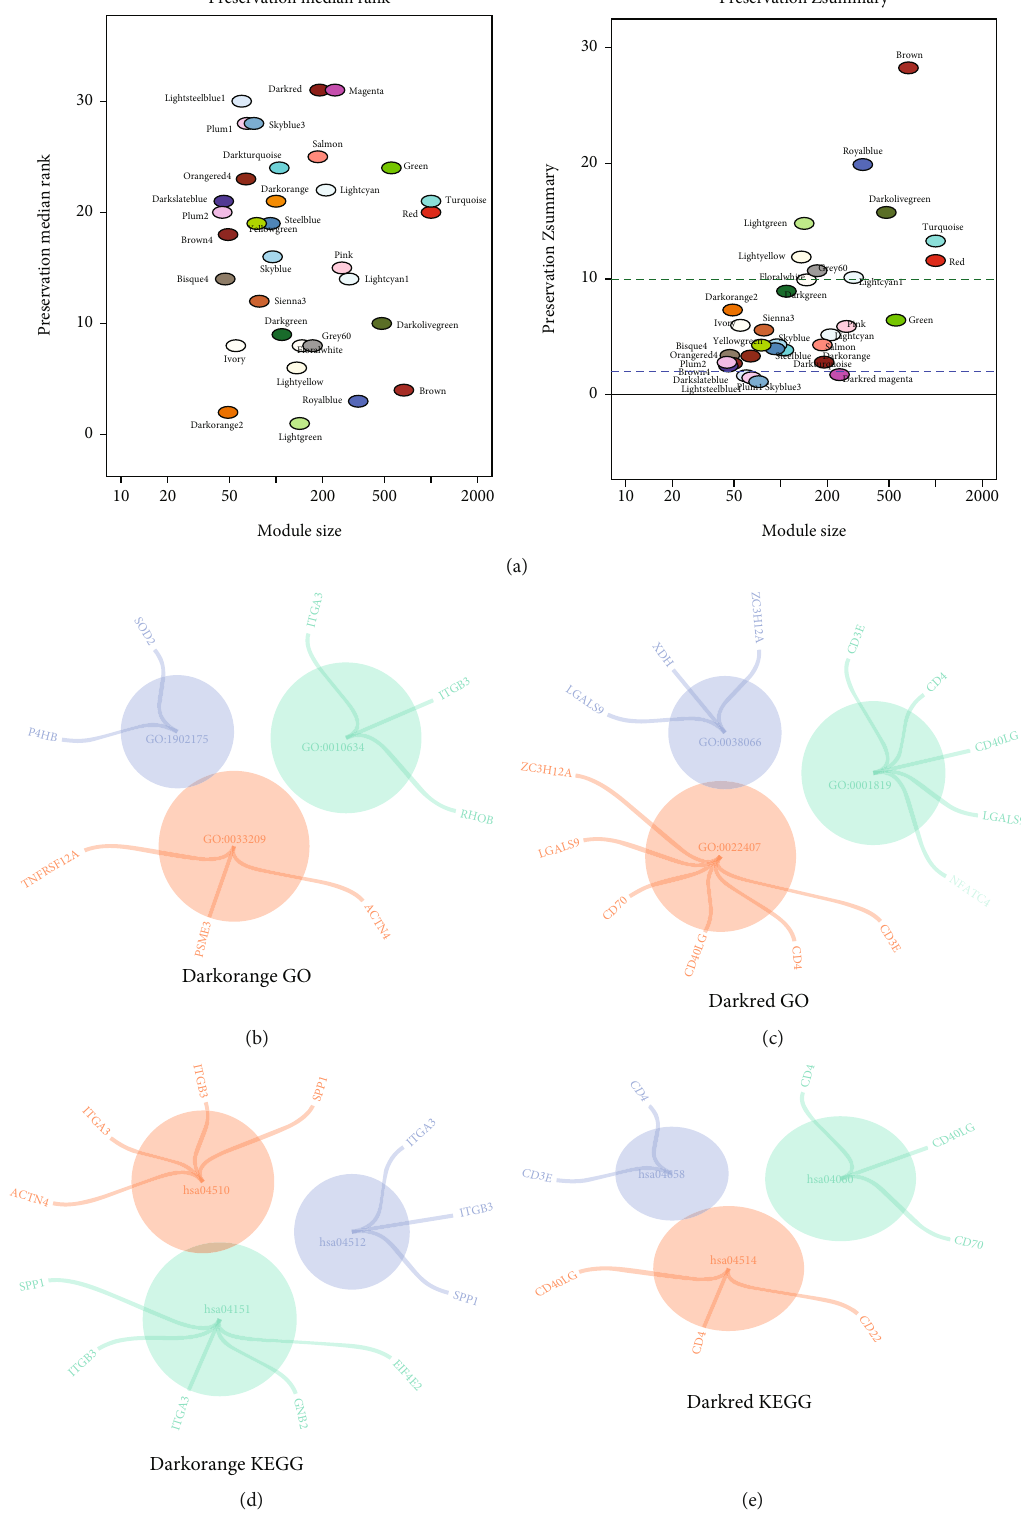
Figure 2: Characterizations of gene modules in WGCNA. (a) Preservation median rank and Z summary score of all modules were presented. The lowest Z summary statistics indicates nonconserved modules. The top two gene modules most signi fi cantly related with DN (dark orange, dark red) were selected for further analysis. The blue and green dotted lines indicate the thresholds Z = 2 and Z = 10 , respectively. (b, c) GO enrichment results for dark orange and dark red modules. (d, e) KEGG pathway enrichment results for dark orange and dark red modules. GO: Gene Ontology; KEGG: Kyoto Encyclopedia of Genes and